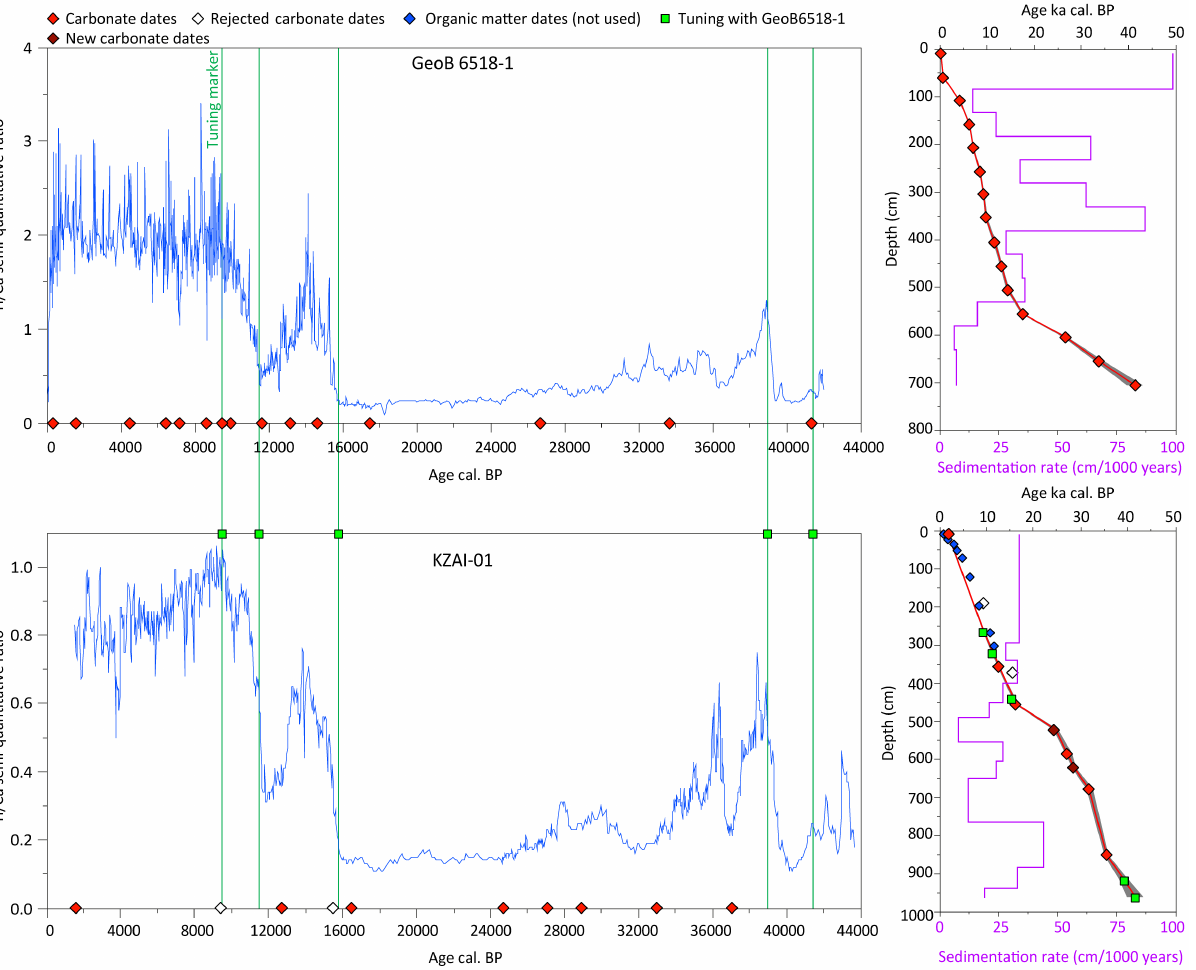
Figure 2. Age model established through a linear regression between retained AMS 14 C pointers (red squares; cf. Table 1). Blue squares correspond to 14 C dates acquired on organic matter (Bayon et al., 2012); not taken into account for the age model. Green squares correspond to dates obtained by tuning the KZAI-01 core with GeoB6518 core, on the basis on similar XRF Ti / Ca ratio trends. Grey band corresponds to the 2 σ range error of calibrated dates, and purple lines correspond to sedimentation rates (cmkyr − 1